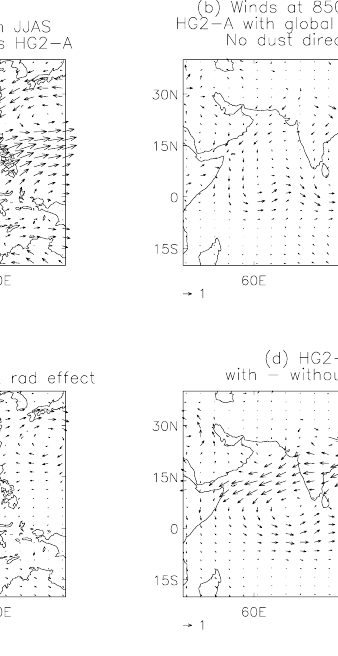
Fig. 9. As Fig. 8 but for horizontal wind at 850hPa.